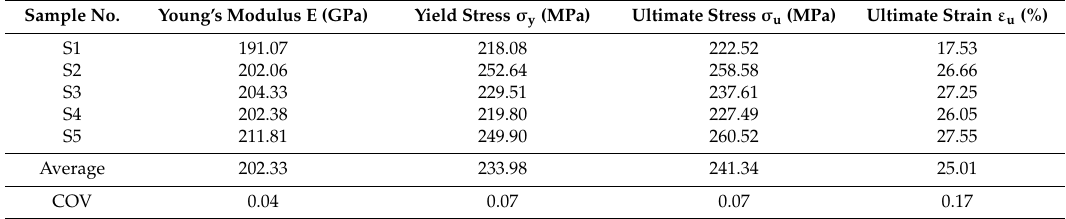
Figure 6. Details of the tensile test: ( a ) dimensions of the tensile coupon; and ( b ) stress–strain curves of the material. Table 1. Material properties obtained from the tension coupon tests .